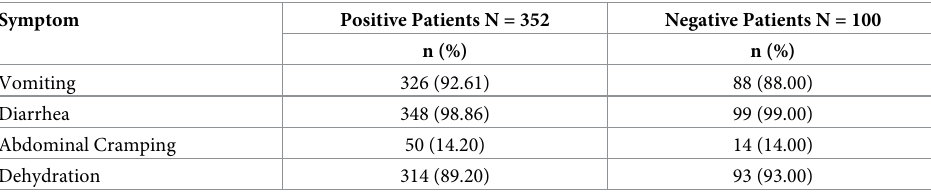
Table 3. Symptoms of cholera positive and negative